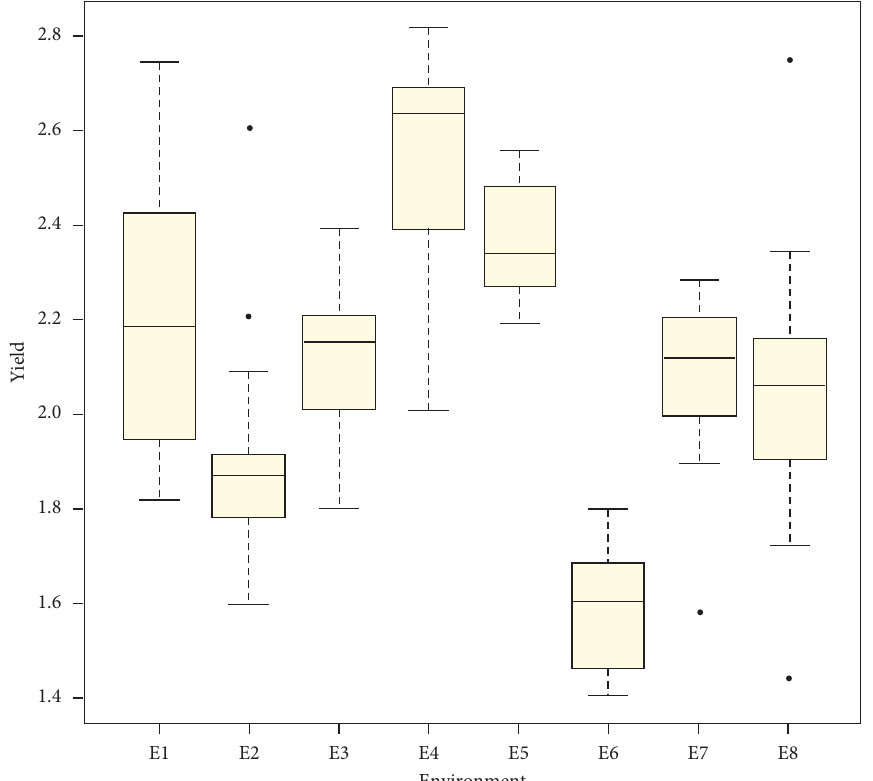
Figure 1: GEIs box plot from eight environments on 13 soybean lines in Indonesia. E 1 � Ngawi (2016), E 2 � Banyuwangi (2016), E 3 � Banyuwangi (2017), E 4 � Ngawi (2017), E 5 � Probolinggo (2018), E 6 � Malang (2018), E 7 � Bantul (2019), and E 8 � Bogor (2019).